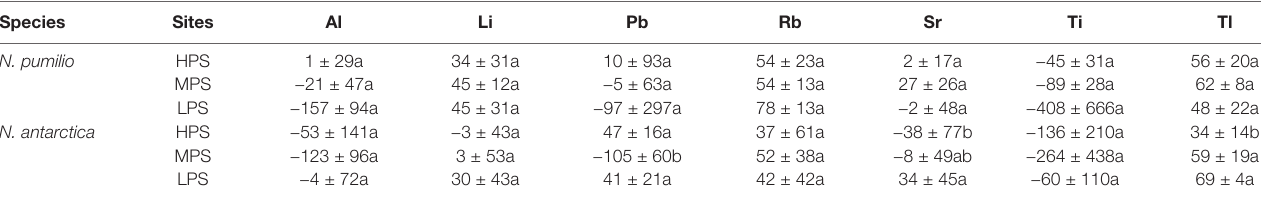
For each species, different letters for the same nutrient indicate significant differences (P < 0.05) between sites. HPS, highly productivity site; MPS, medium productivity site; LPS, low productivity site.